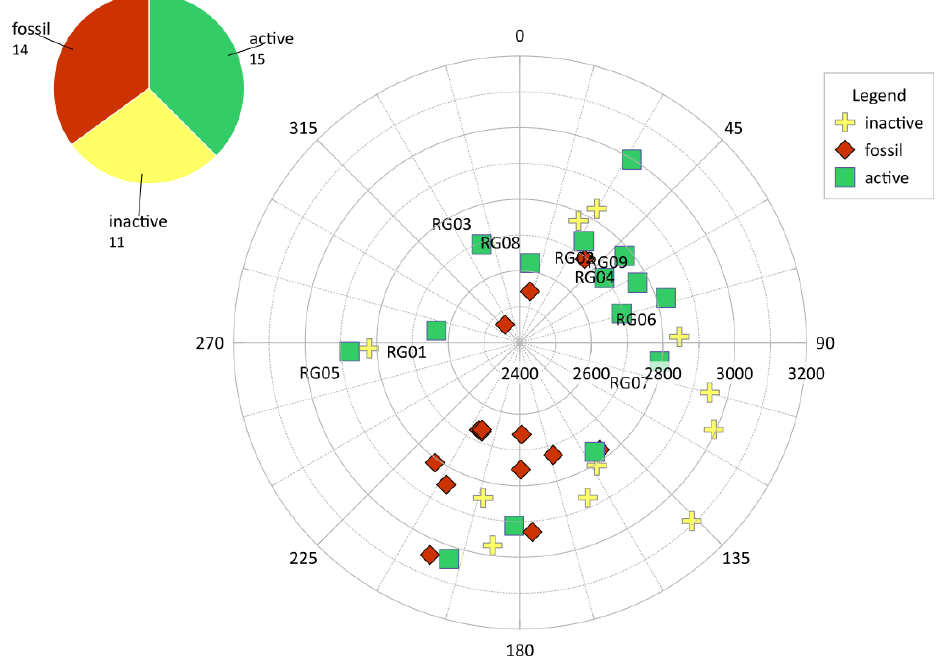
Figure 3. Rose plot of the rock glacier inventory of the upper Kaunertal. The radial axis gives the mean elevation of the rock glaciers [m]; the angular axis gives the aspect of the rock glaciers [ ◦ ]. Table 4. Characteristics of the rock glaciers studied. Permafrost occurrence gives the pseudo-probability of permafrost (Otto et al., 2020). Area covered by 1850 glacier extent is ascertained according to LIA glacier extents (Fischer et al., 2015) if not specified otherwise. Rock